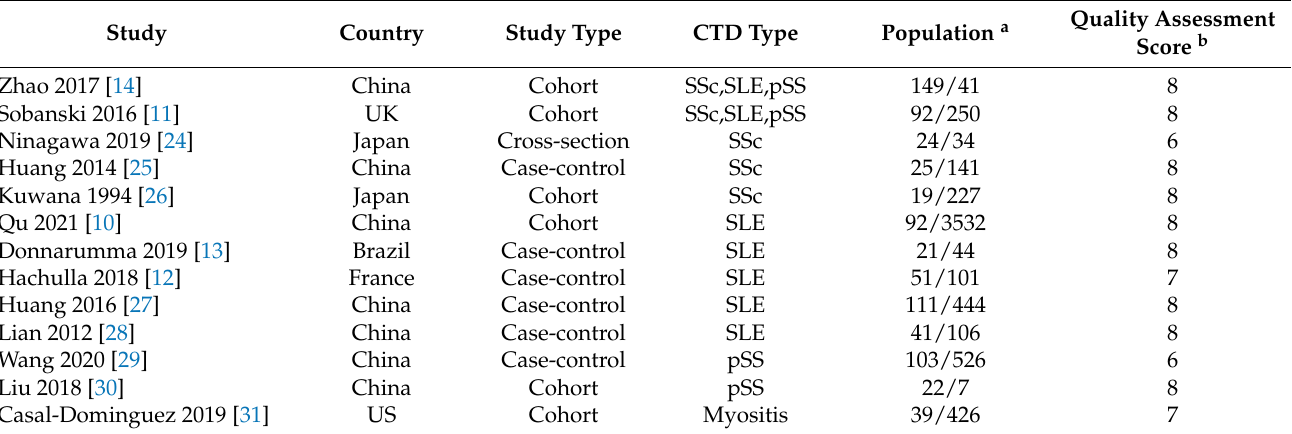
Figure 1. Flow diagram demonstrating the process of study selection. CTD-PAH: connective tissue disease-associated pulmonary arterial hypertension; RNP: ribonucleoprotein. Table 1. Basic characteristics and quality evaluation outcomes of included studies. CTD: connective tissue disease; SSc: systemic sclerosis; SLE: systemic lupus erythematosus; pSS: primary Sjogren’s syndrome; PAH: pulmonary arterial hypertension; RHC: right heart catheterization; NA: not available.